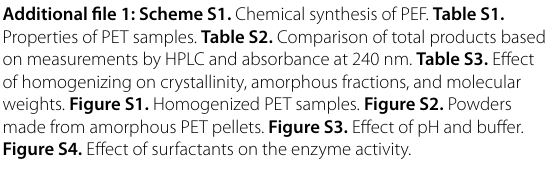
Figure S4. Effect of surfactants on the enzyme